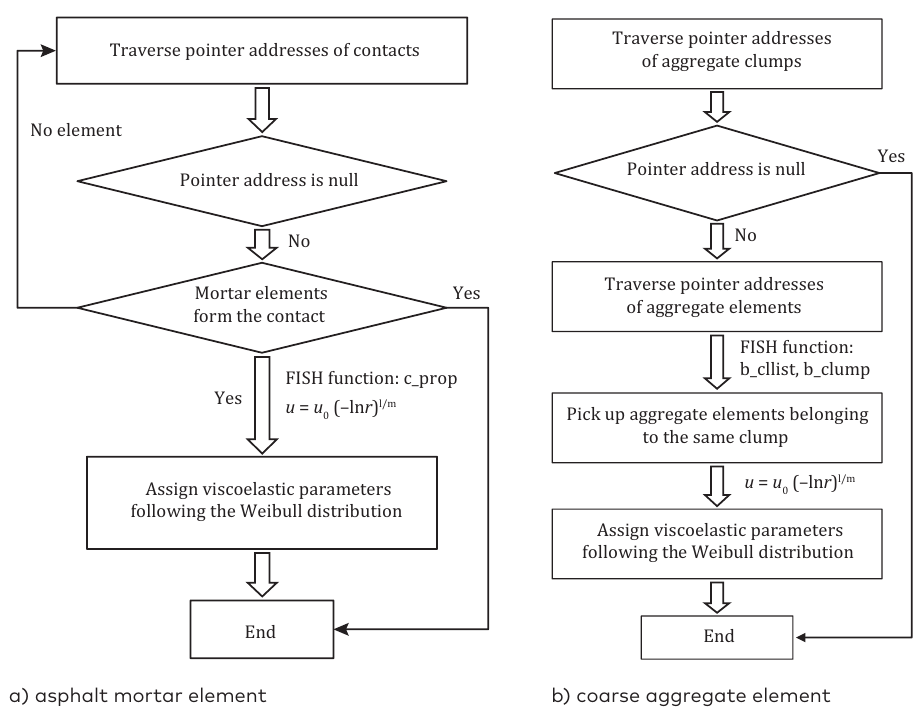
Figure 13. Procedure for assigning micro-parameters of coarse aggregates and asphalt